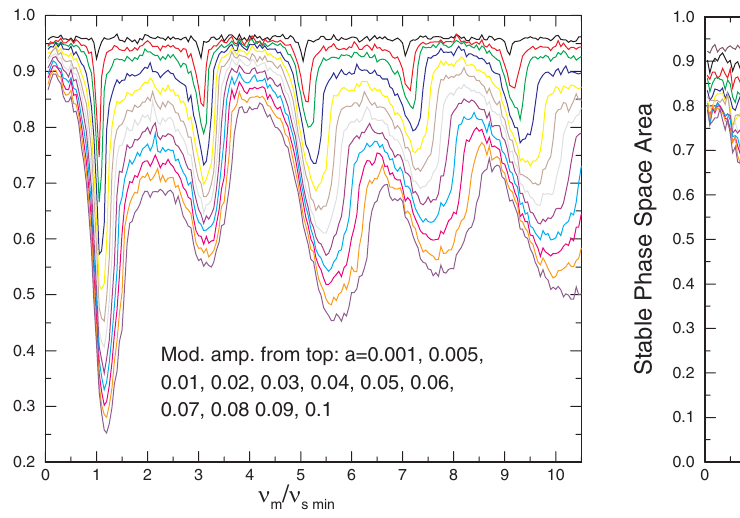
FIG. 11. (Color) Same as Fig. 10, but the simulation duration for every point has been increased 10 times, to 1000 synchrotron , about 486 s or 8.1 min. The periods, with respect to (cid:4) s; min chaotic behavior becomes more apparent. Note that the vertical scale is different from that of Fig.